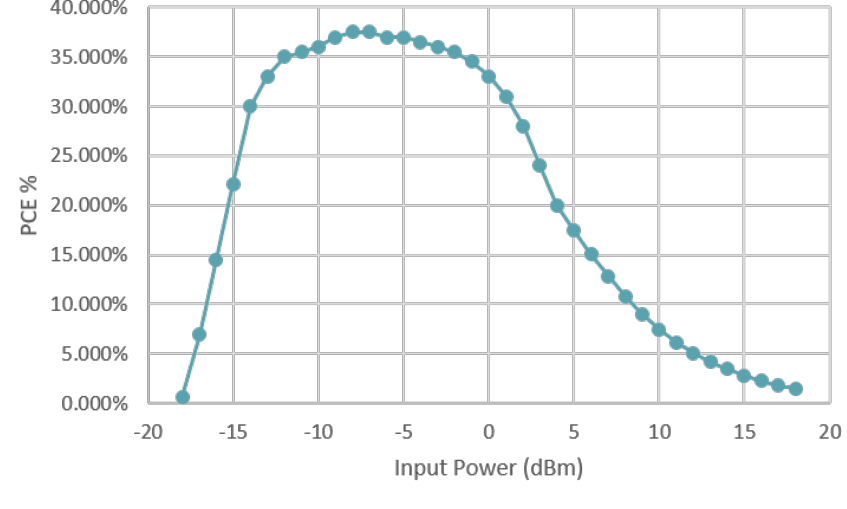
Figure 7. PCE vs. input power at 868 MHz.